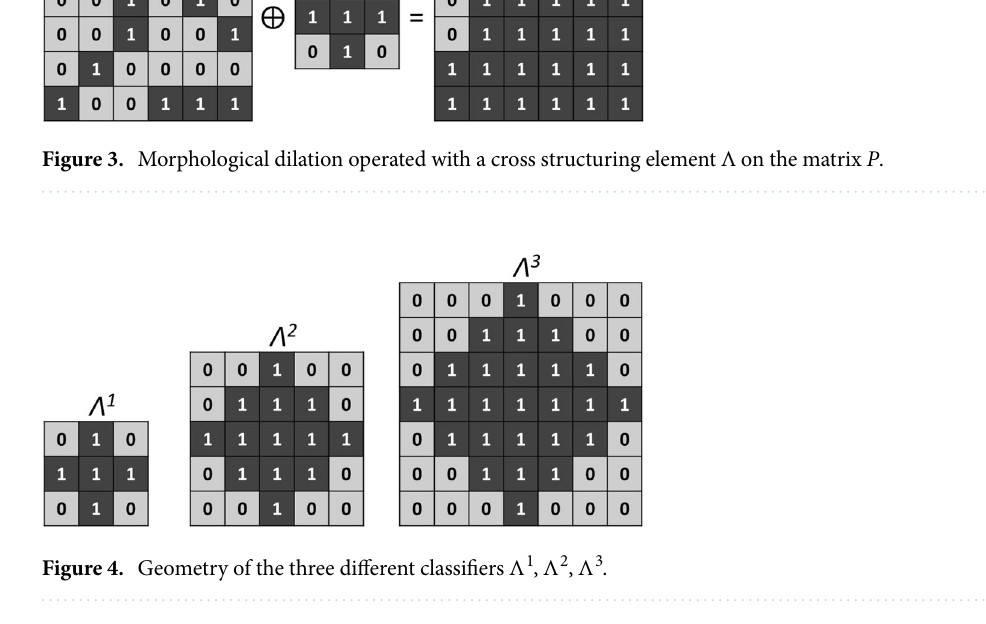
Figure 4. Geometry of the three different classifiers (cid:31)